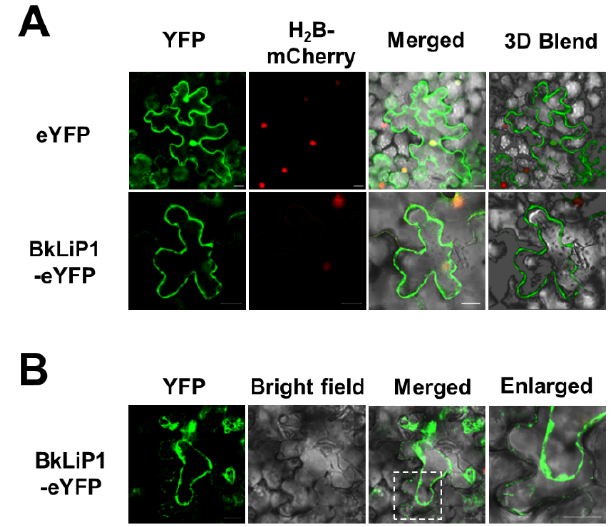
Figure 5. Subcellular localization analysis of BkLiP1 N. benthamiana . ( A ) Subcellular localization of BkLiP1 in epidermal cells of N. benthamiana leaves. The fungal protein BkLiP1 was expressed as fused to the N-terminus of eYFP. The fusion protein H 2 B-mCherry was used as a nucleus marker. The same imaging conditions were used in the three channels and 3D Blend projection. ( B ) Subcellular localization of BkLiP1 in epidermal cells of N. benthamiana leaves after plasmolysis. The enlarged section of each image was highlighted with a box. Images were acquired 2 days after agroinfiltration under confocal laser scanning microscopy. The images show maximum projections of 4 confocal images captured along the z -axis. Scale bar = 20 µm.